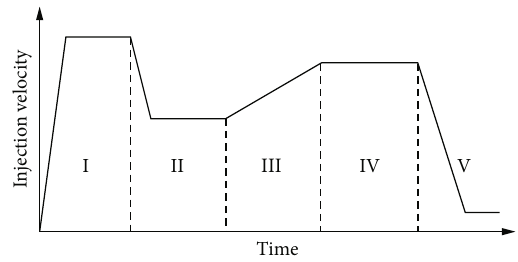
Figure 2: Injection velocity pro fi le during the injection